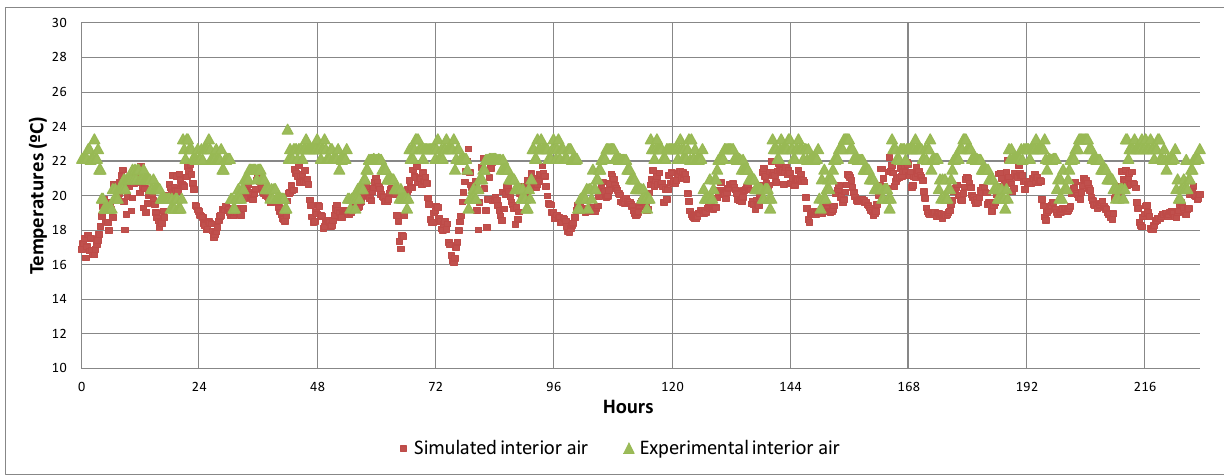
Figure 7. Measured and predicted temperatures of the air inside the